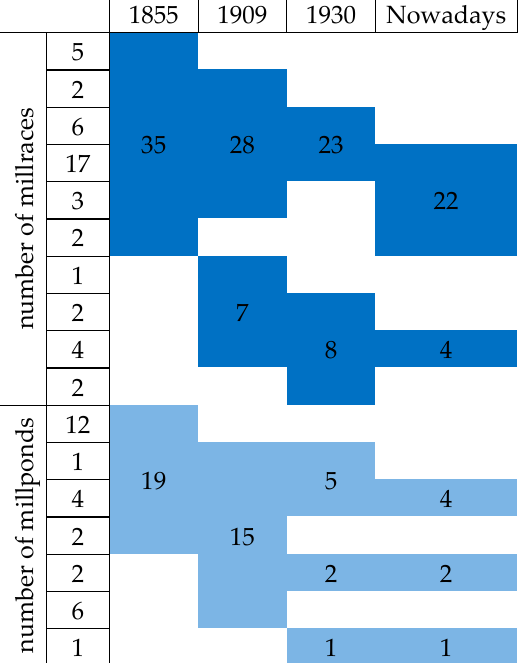
Figure 5. The continuity of operation of millraces in the River Skawa catchment area since 1855. Blue cells (both shades) indicate a period of uninterrupted operation.